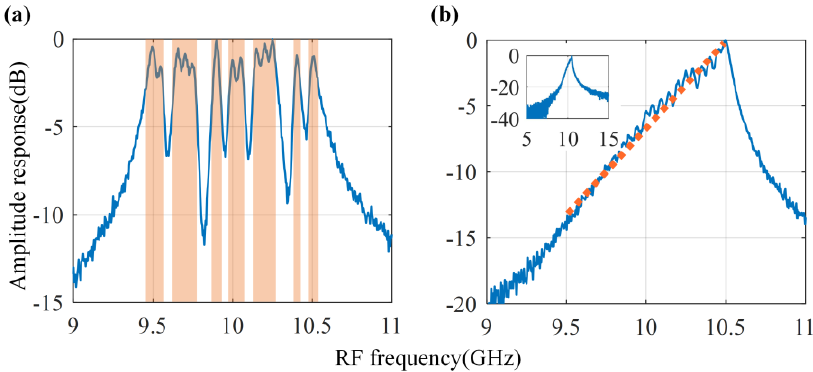
Figure 4. ( a ) The frequency response when the RF channels are turned on randomly. ( b ) The response when the channel amplitudes are set to linearly increase (in dB).